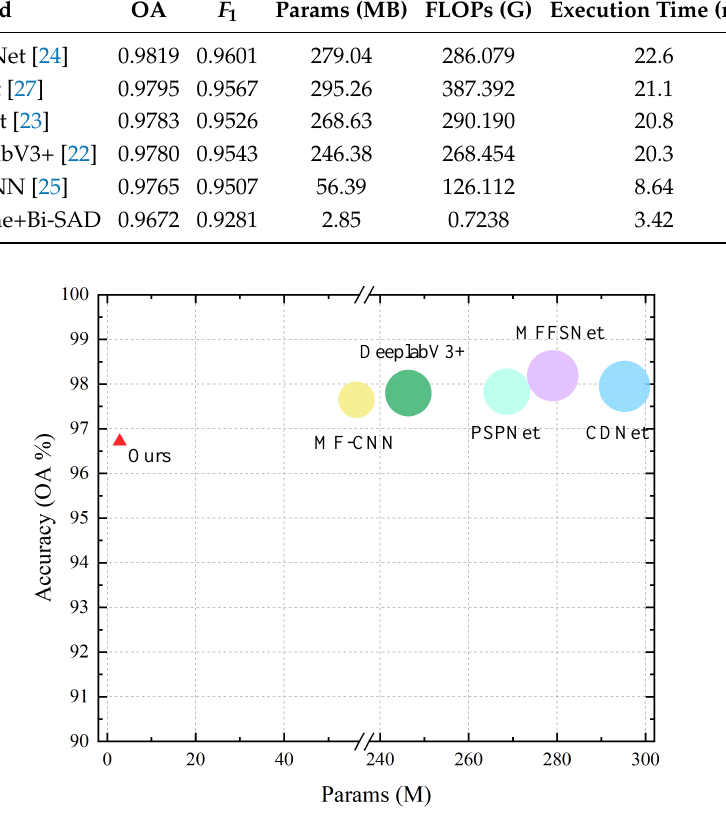
Figure 10. The accuracy, parameters, and floating-point operations (FLOPs) of different deep convolutional neural networks (DCNNs) on the GaoFen-1 cloud detection dataset, including our method, MFFSNet [24], CDNet [27], PSPNet [23], DeeplabV3+ [22], and MFCNN [25]. The FLOPs are represented by the size of corresponding labels (circle or triangle in the picture), which means the bigger the label, the larger the FLOPs. Compared with with the state-of-the-art deep learning based cloud detection models, our method uses fewer parameters and FLOPs to achieve comparable